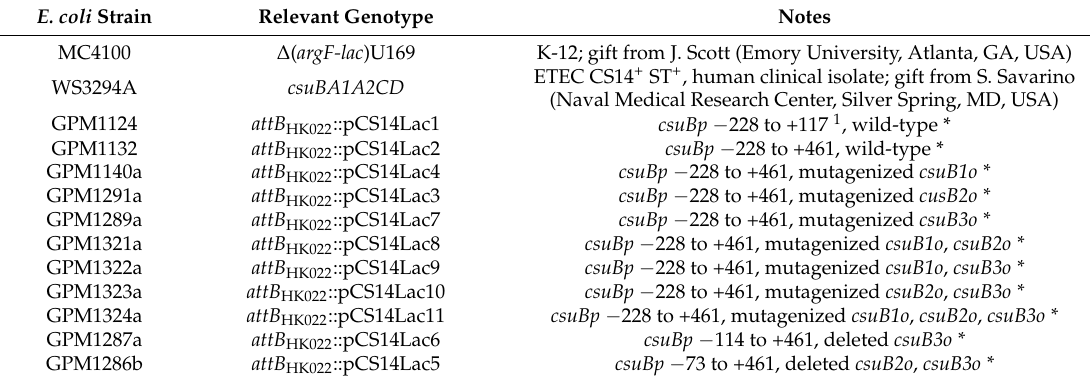
Table 1. Bacterial strains.